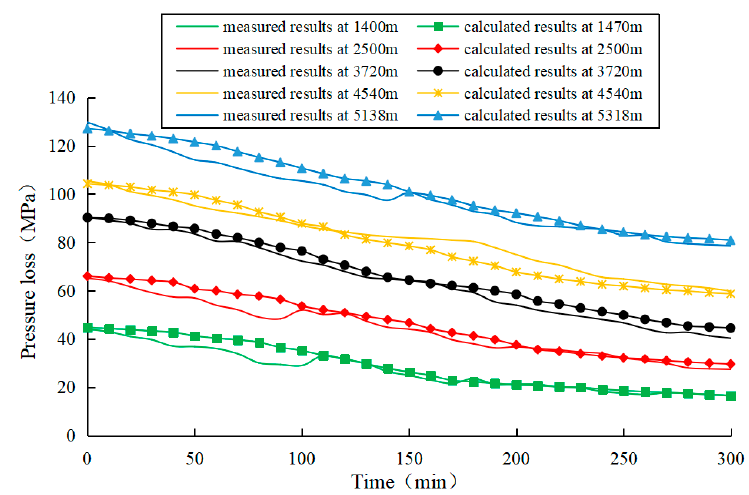
Figure 9. Comparison of calculated pressures and measured pressures.